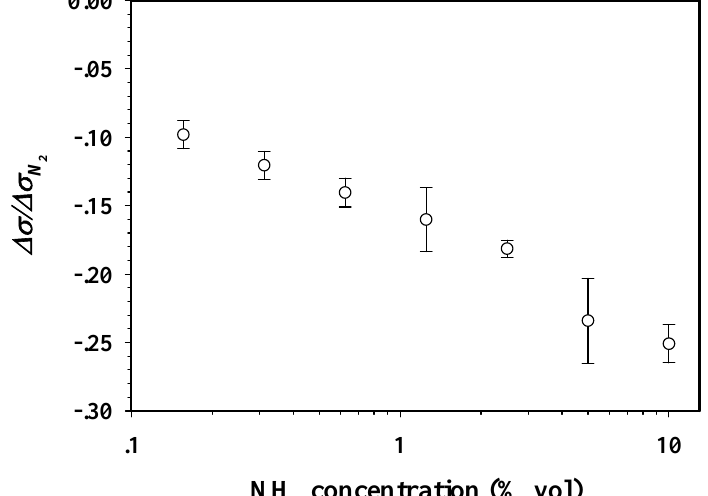
NH concentration (% 3